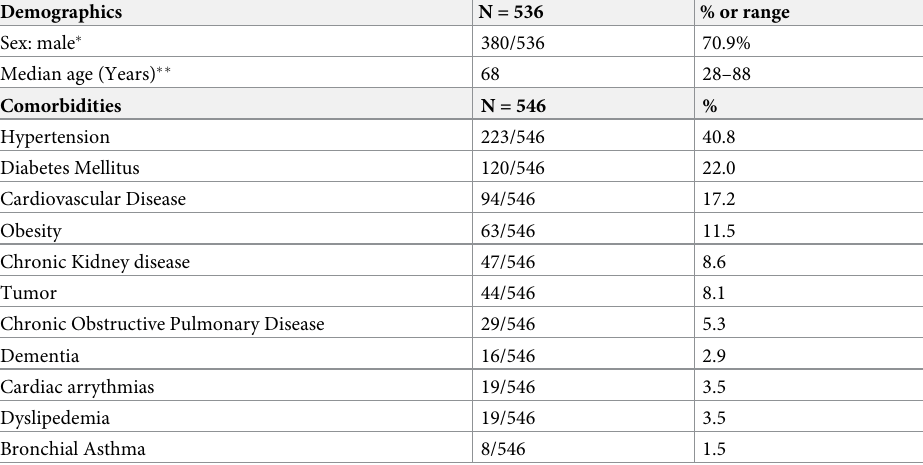
Table 2. Demographics and medical history of the COVID-19